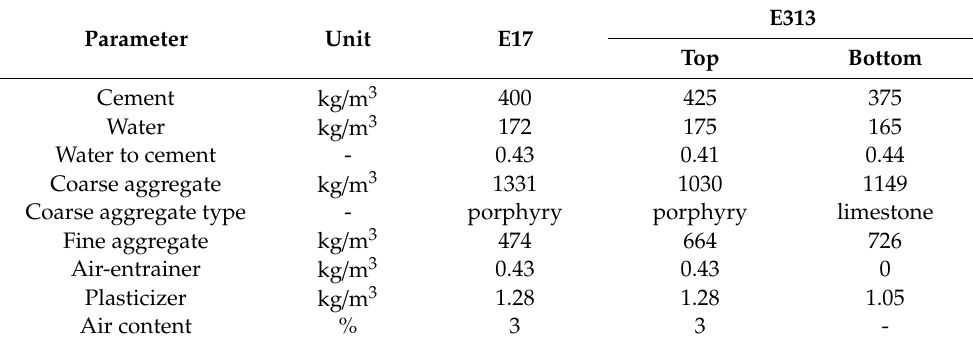
Figure 1. The concrete specimen shape and dimension, in mm. Table 1. Concrete Mixture